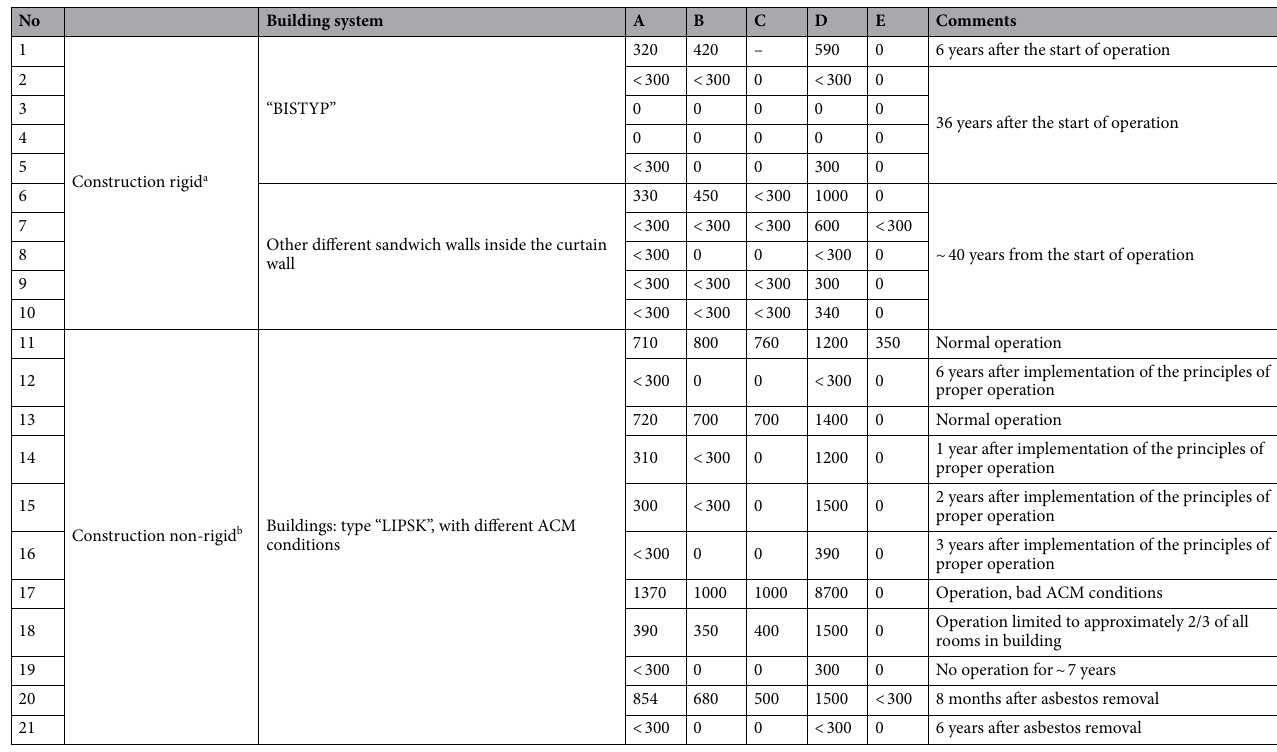
Table 2. Indoor air pollutant concentrations for several typical asbestos building systems. (A—Average value from 20–200 tests of asbestos respirable fiber concentrations in all tested rooms; B—Median of recorded values; C—Mode—the value with the highest probability of occurrence; D—The highest concentration of fibers in the air; E—The lowest concentration of fibers in the air). a A long-wall structure with brick walls or frame structure, reinforced concrete, containing sandwich element with asbestos-cement plates. b Lightweight